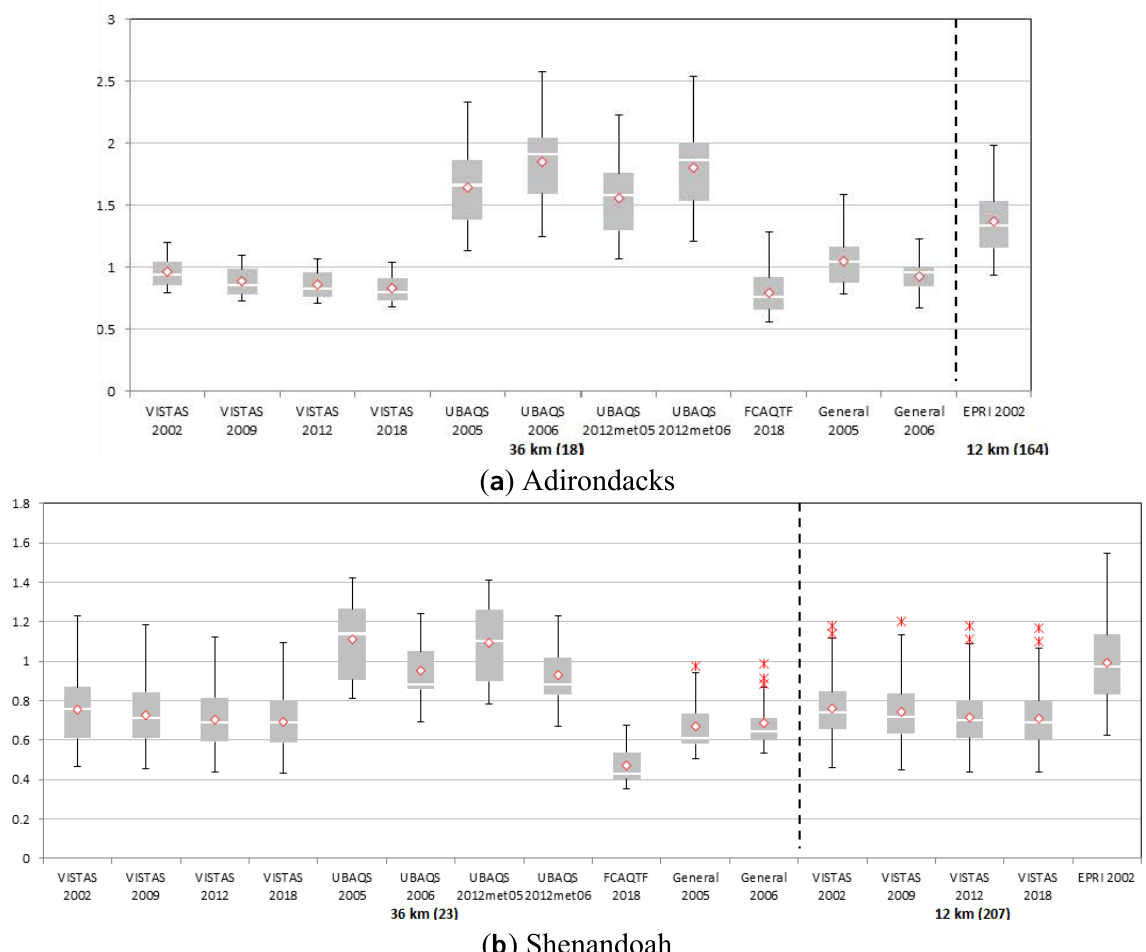
Figure 6. Box and whisker plots for variability in TSO ( b ) Shenandoah across all the model simulations. The number in parentheses represents the number of each sample data. How to read a box and whisker plot is explained in the Figure 5